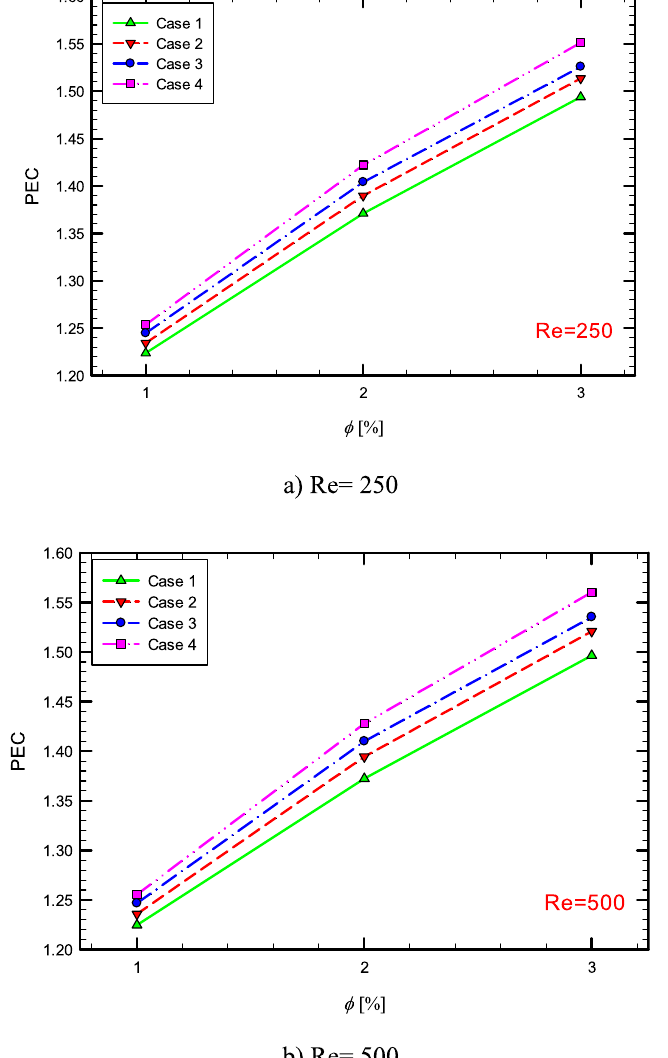
Figure 46. PEC versus φ at different Reynolds